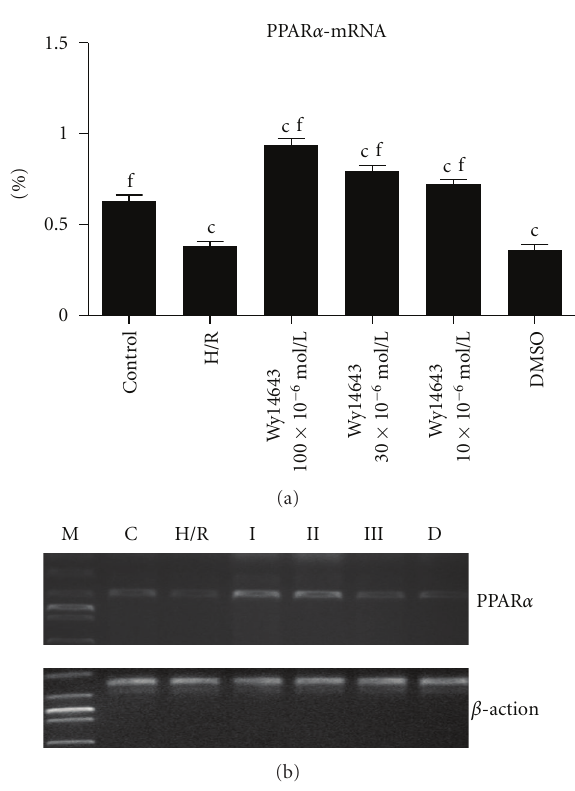
Figure 4: After 4 h of hepatocellular hypoxia and 10h of reoxy- genation. E ff ect of hypoxia and reoxygenation on PPAR α -mRNA expression in hepatocytes. (Mean ± SD, n = 6) c P < 0 . 01 versus control group; e P < 0 . 05, f P < 0 . 01 versus H/R group. (C: control group; H/R: hypoxia/reoxygenation group; I: Wy14643 group 100 × 10 − 6 mol/L; II: Wy14643 group 30 × 10 − 6 mol/L; III: Wy14643 group 10 × 10 − 6 mol/L; D: DMSO